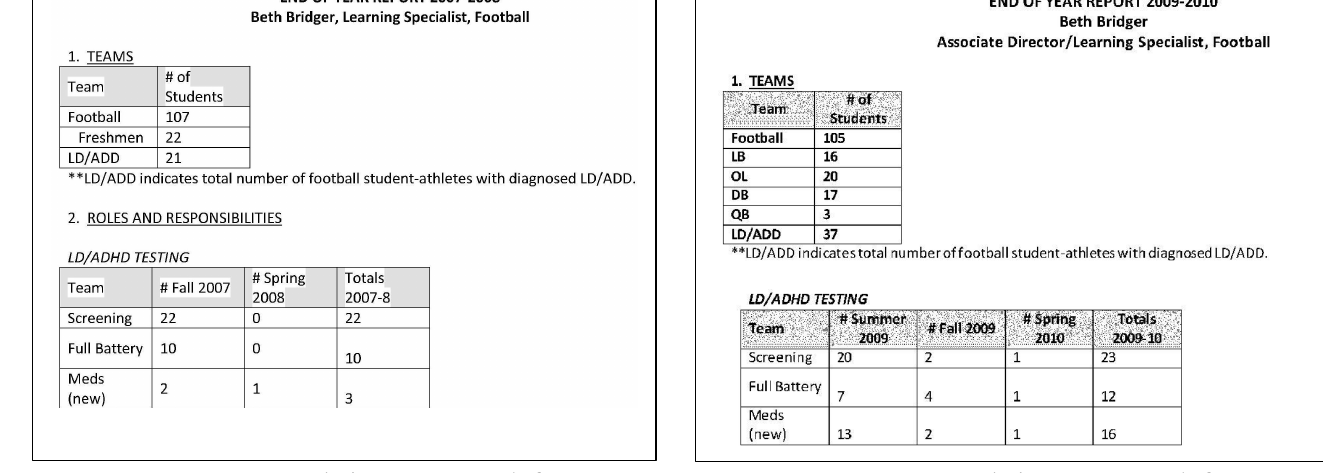
Figure 3: UNC Learning Specialist's 2009-2010 End-of-Year Report Detailing Football Team LD/ADHD Incidence and Medication Prescription